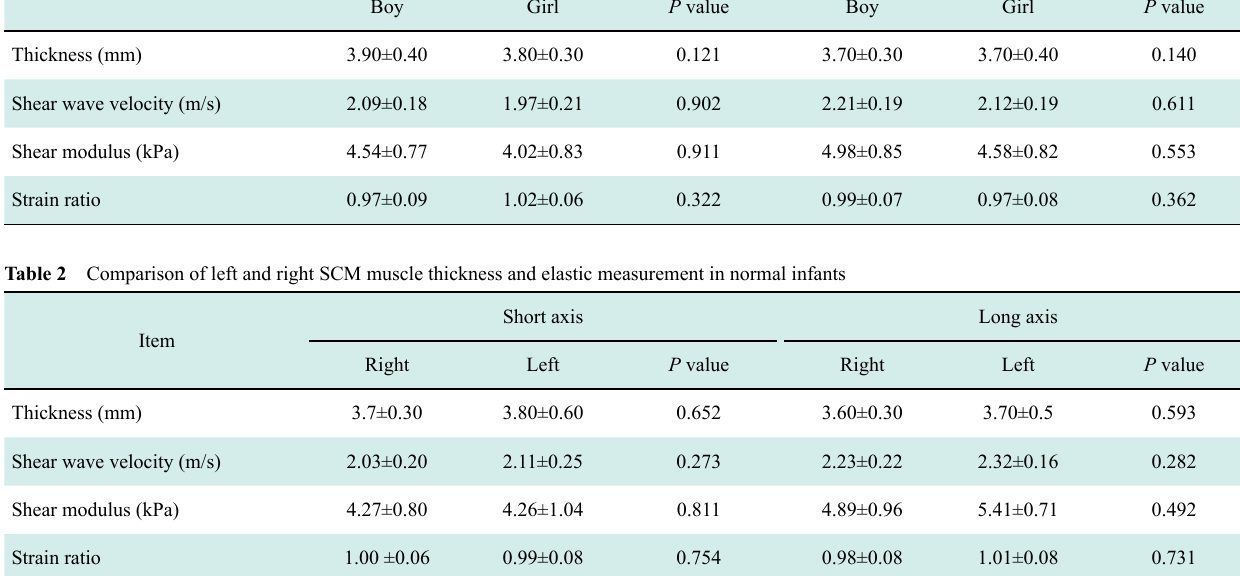
Table 1 Comparison of SCM muscle thickness and elastic measurement of boy and girl infants in normal group Item